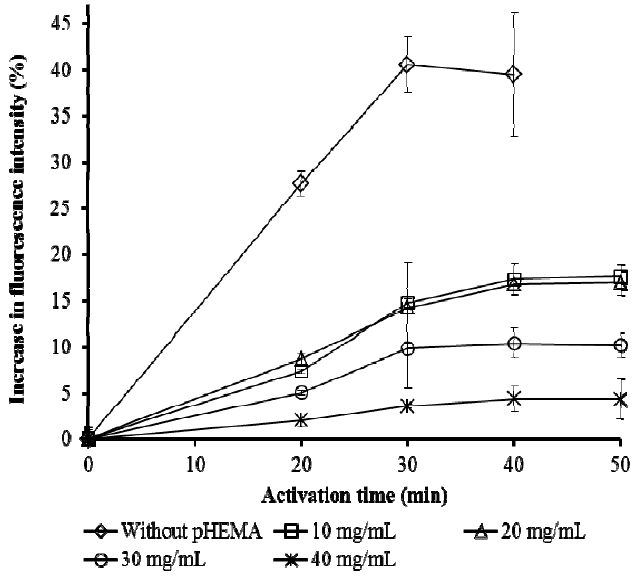
Figure 3. Effect of different amount of pHEMA on activation time (n =